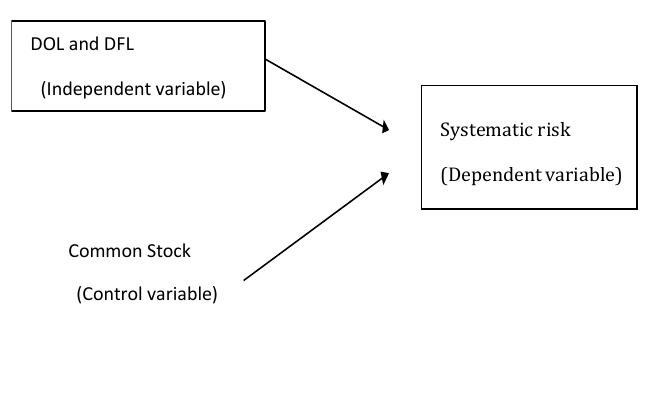
Figure 1: Conceptual